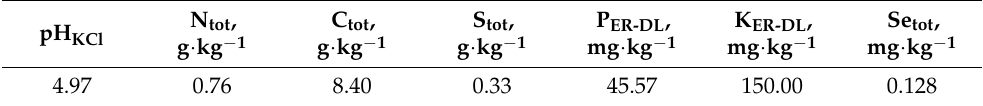
Table 1. Agrochemical properties of the soil.